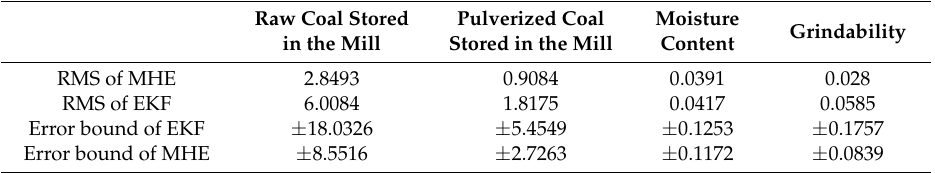
Figure 10. Controlled variable estimates. ( a ) Mill outlet temperature; ( b ) Primary air mass flow; ( c ) Pulverized coal flow into the furnace. Table 6. RMS errors and 3-sigma error bounds of the estimates.